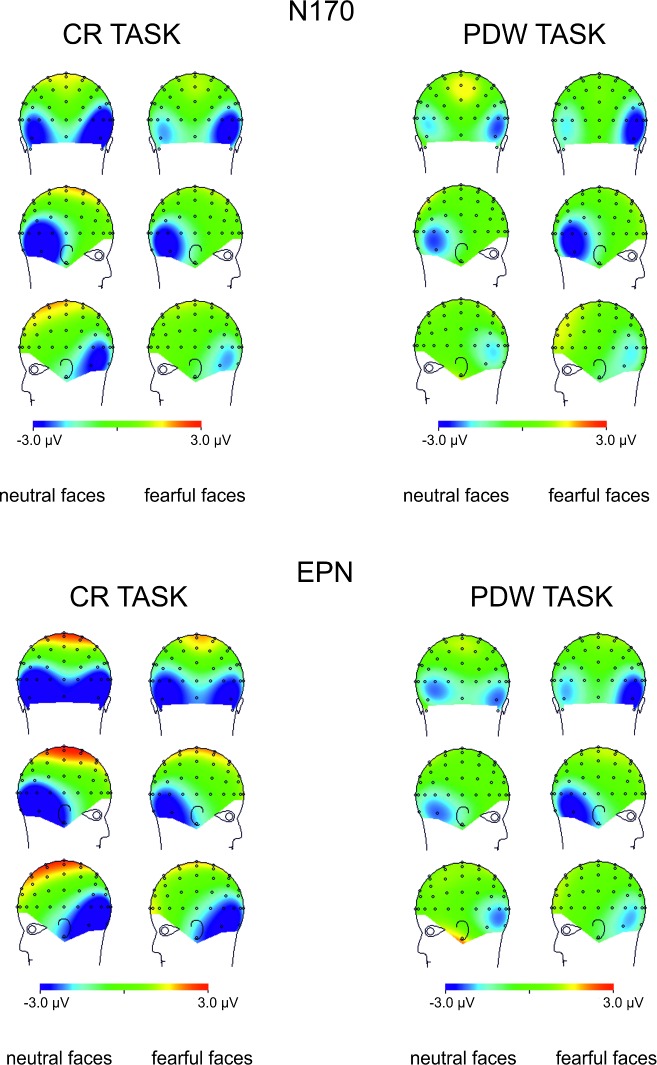
Topographical maps representing voltage differences between brain activity recorded in “aware” and “unaware” trials in the N170 and EPN components time interval (145-180ms post-stimulus and 240-340ms post-stimulus, respectively) illustrated separately for responses to neutral and fearful faces.